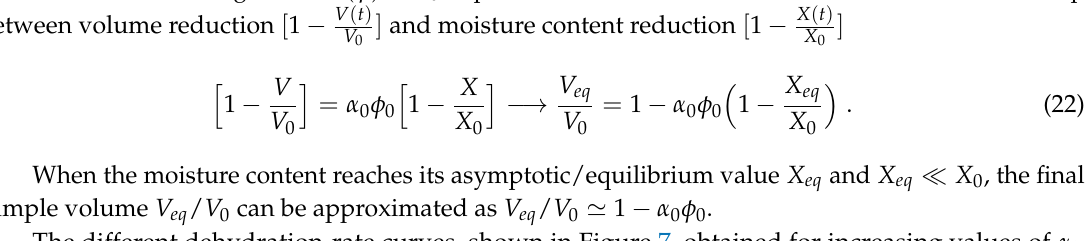
= β shell = 1 (continuous lines) and for 0 0 = 0.9,0.8. Arrows indicate decreasing 0